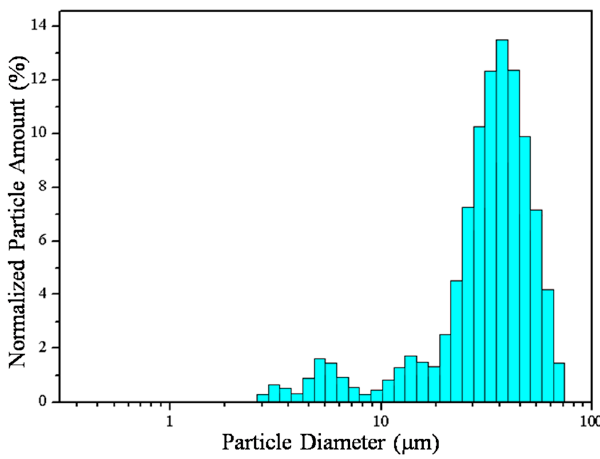
Figure 3. Particle size distribution of DP25B75 powder.